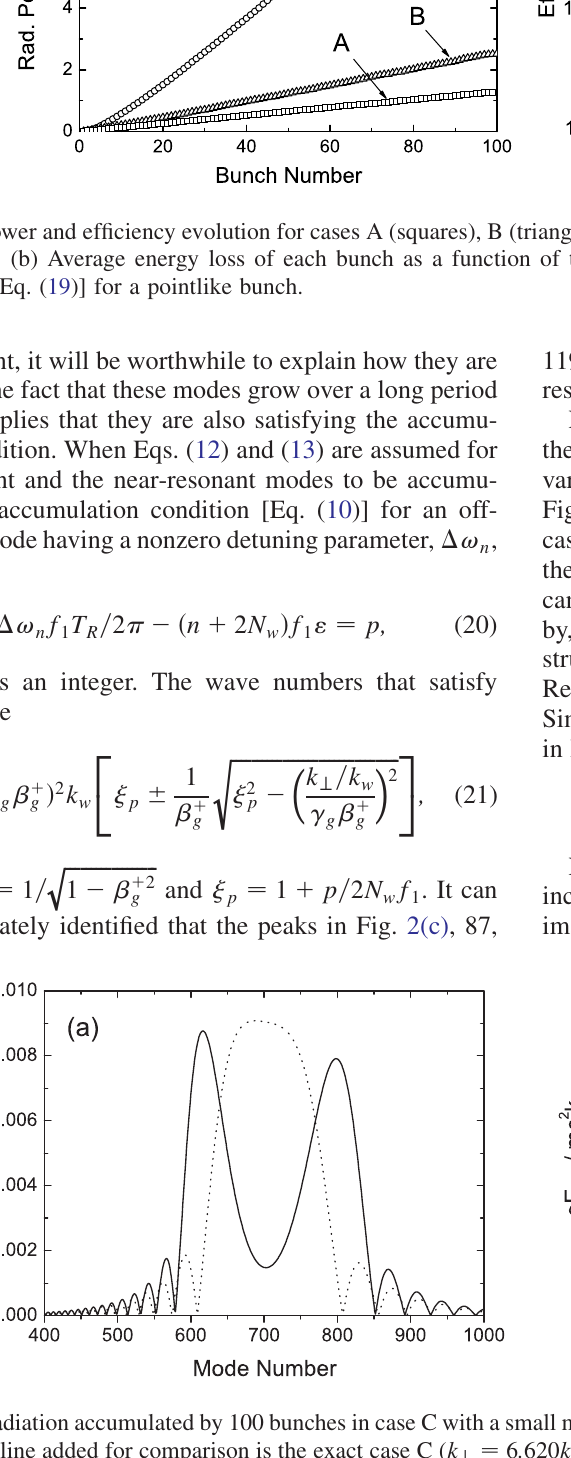
FIG. 4. Radiation accumulated by 100 bunches in case C with a small mismatch in k ? : k ? ¼ 6 : 596 k The broken line added for comparison is the exact case C ( k ? ¼ 6 : 620 k produced from